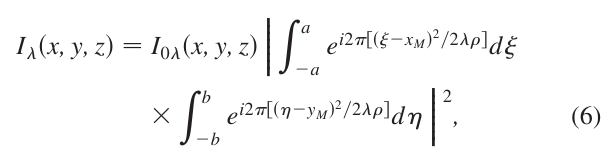
FIG. 4. (Color) PSF rms width vs photon energy for several apertures in pinhole